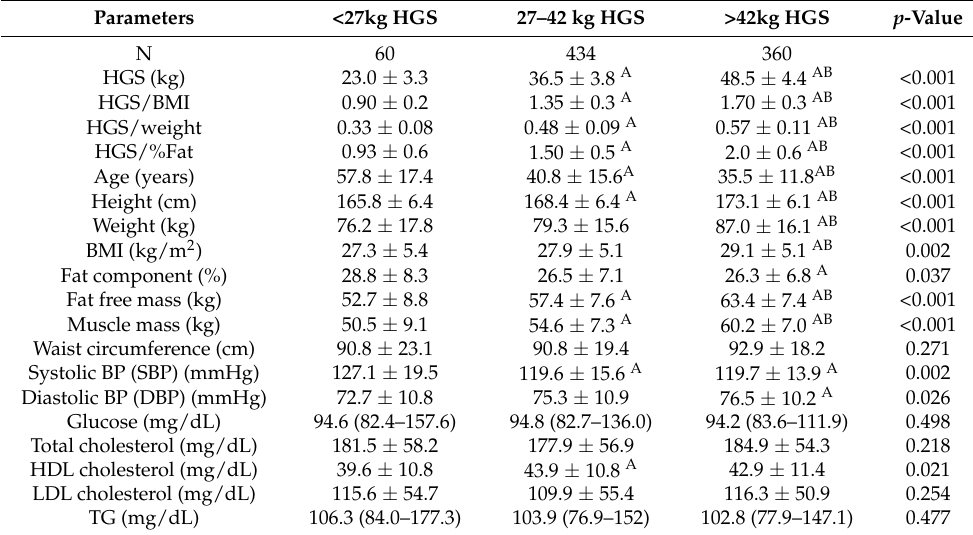
Table 1. Differences in handgrip strength between subgroups based on body composition, metabolic markers, and handgrip strength